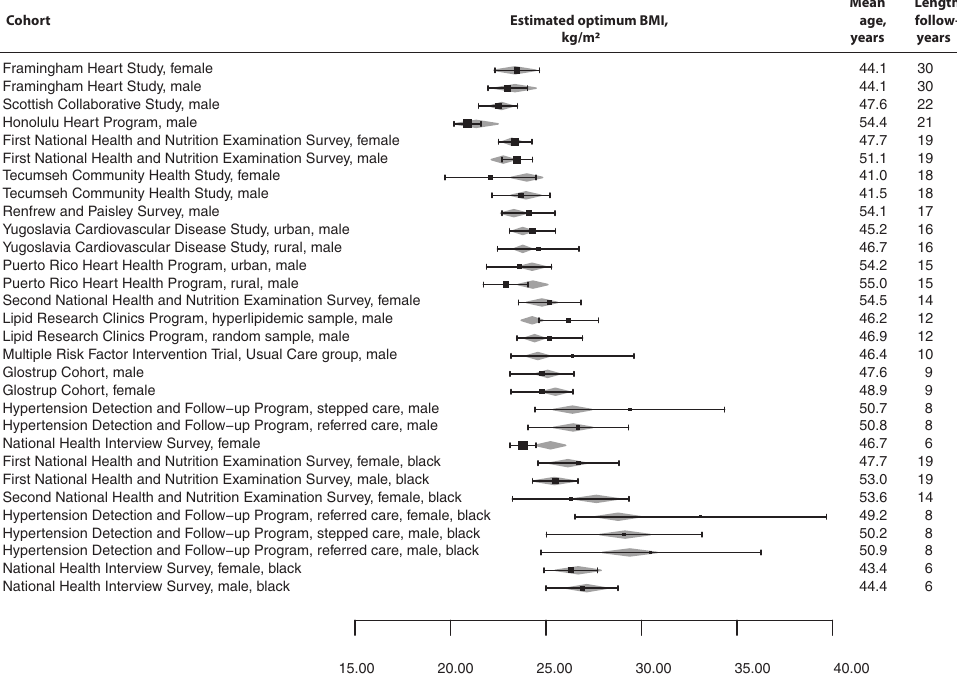
Fig. 1. Forest plot showing observed optima (black squares) as reported by the Diverse Populations Collaborative Group. Predicted optima (grey rhombs) are based on the fi nal model, which included ethnicity, mean age, years of follow-up, and an age-follow-up interaction term. BMI, body mass